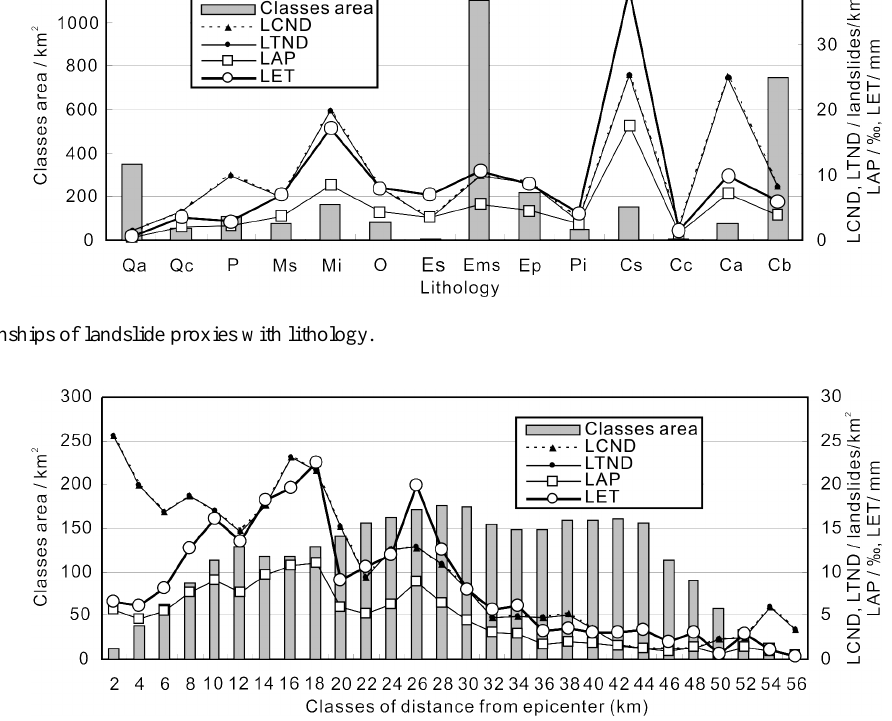
Figure 22. Relationships of co-seismic landslides and distance from epicenter. In all, 28 classes were divided according to 2km intervals from the